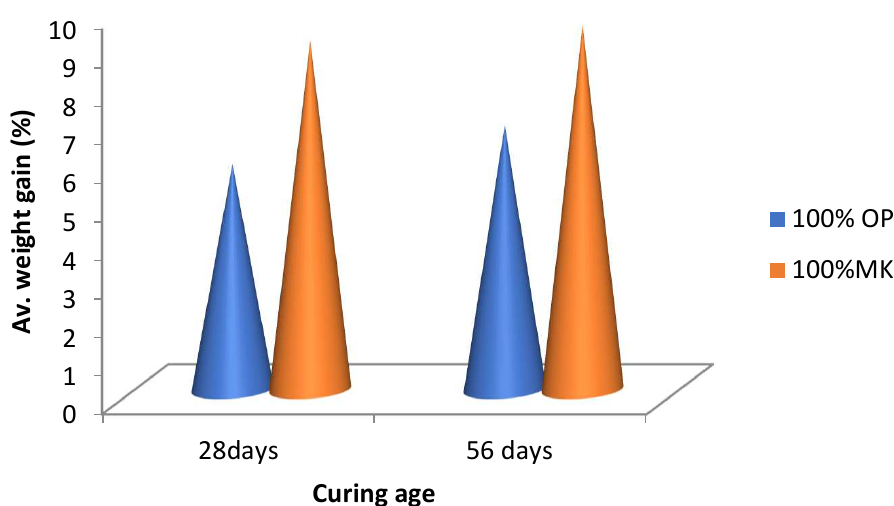
Figure 12. Water absorption capacity of metakaolin-based geopolymer concrete and OPC concrete.